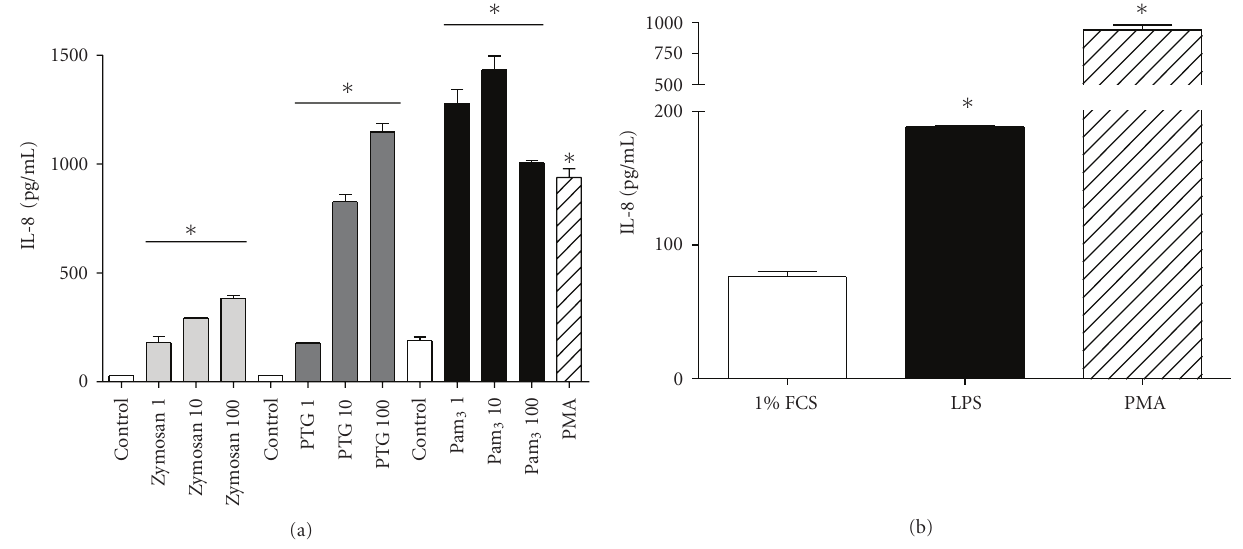
Figure 1: E ff ect of TLR2 and TLR4 agonists on IL-8 production in CFTE29o- cells. Triplicate samples of CFTE29o- cells (1 × 10 5 /mL) were left untreated or treated with (a) 1–100 μ g/mL zymosan, PTG and Pam 3 , or PMA (50ng/mL) in serum-free media for 24 hours, or (b) Pseudomonas LPS (10 μ g/mL) or PMA (50ng/mL) in medium supplemented with 1% FCS for 24 hours. Levels of IL-8 in supernatants were measured by ELISA and values are expressed in pg/mL ( ∗ P ≤ . 05 versus control) ( n =